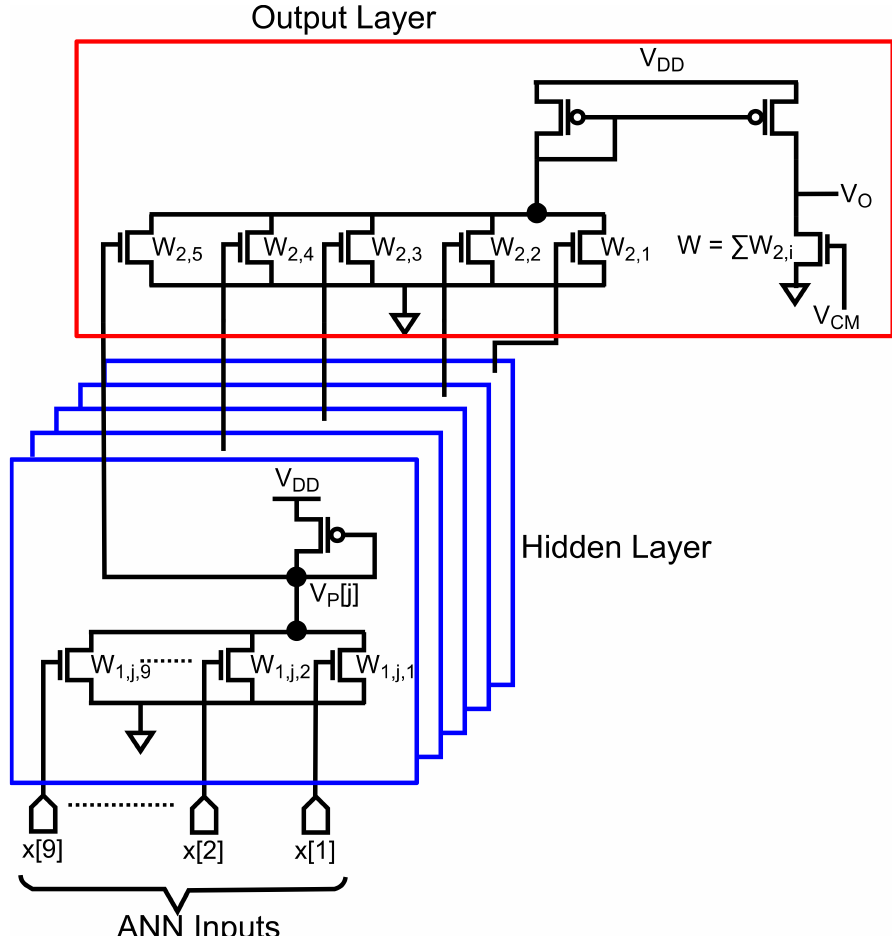
Figure 4. Schematic of ANN for breast cancer